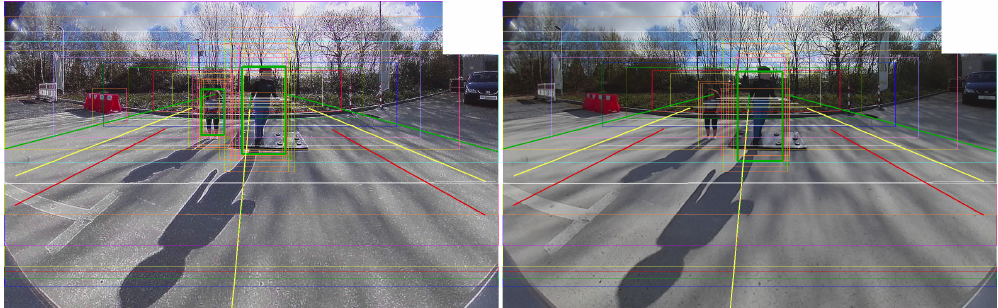
Figure 13. Image after sharpening: (Left: Lap8 & Right: USM9). When the PD algorithm detects a pedestrian, a green bounding box is drawn (all other lines are for